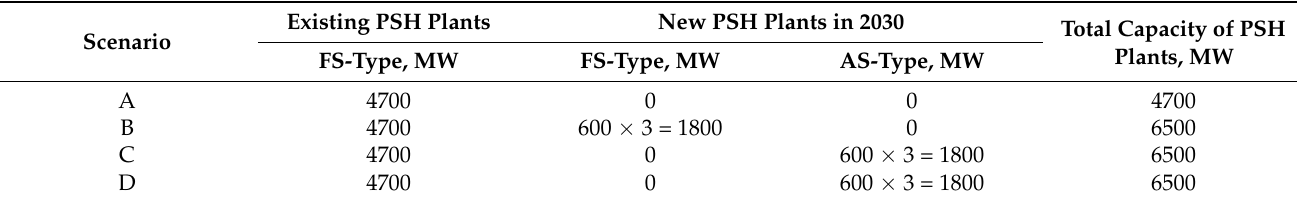
Table 6. Scenario description of RCUC